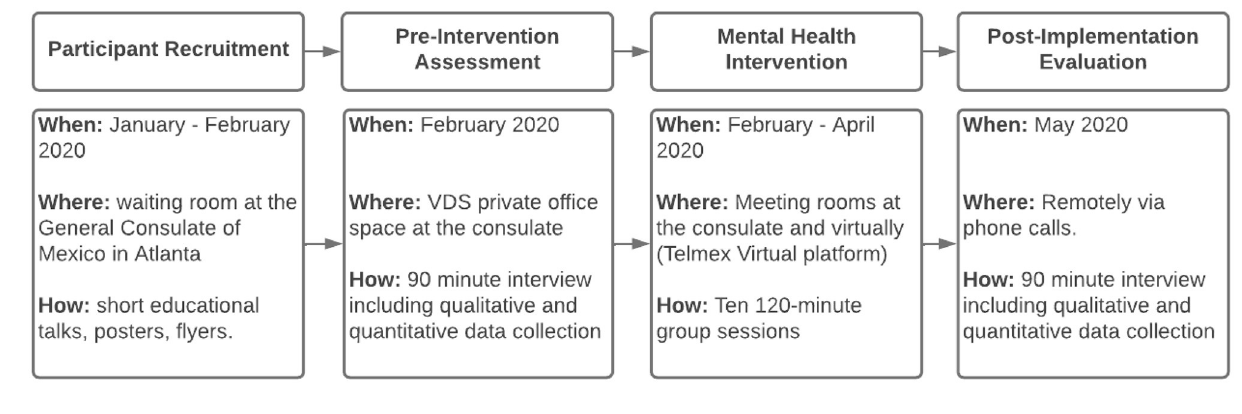
FIGURE 1 | Intervention